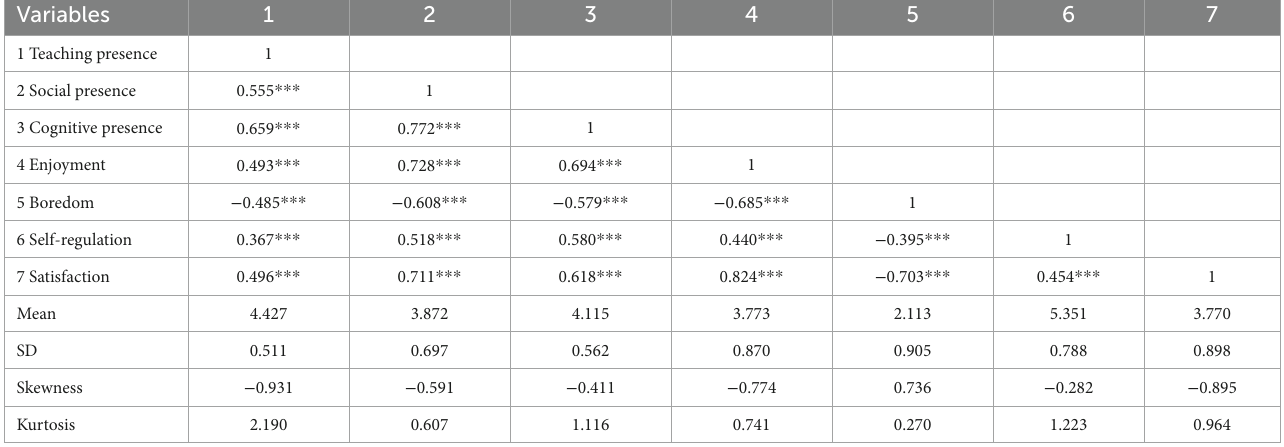
TABLE 2 Descriptive statistics and correlation coefficients between variables.